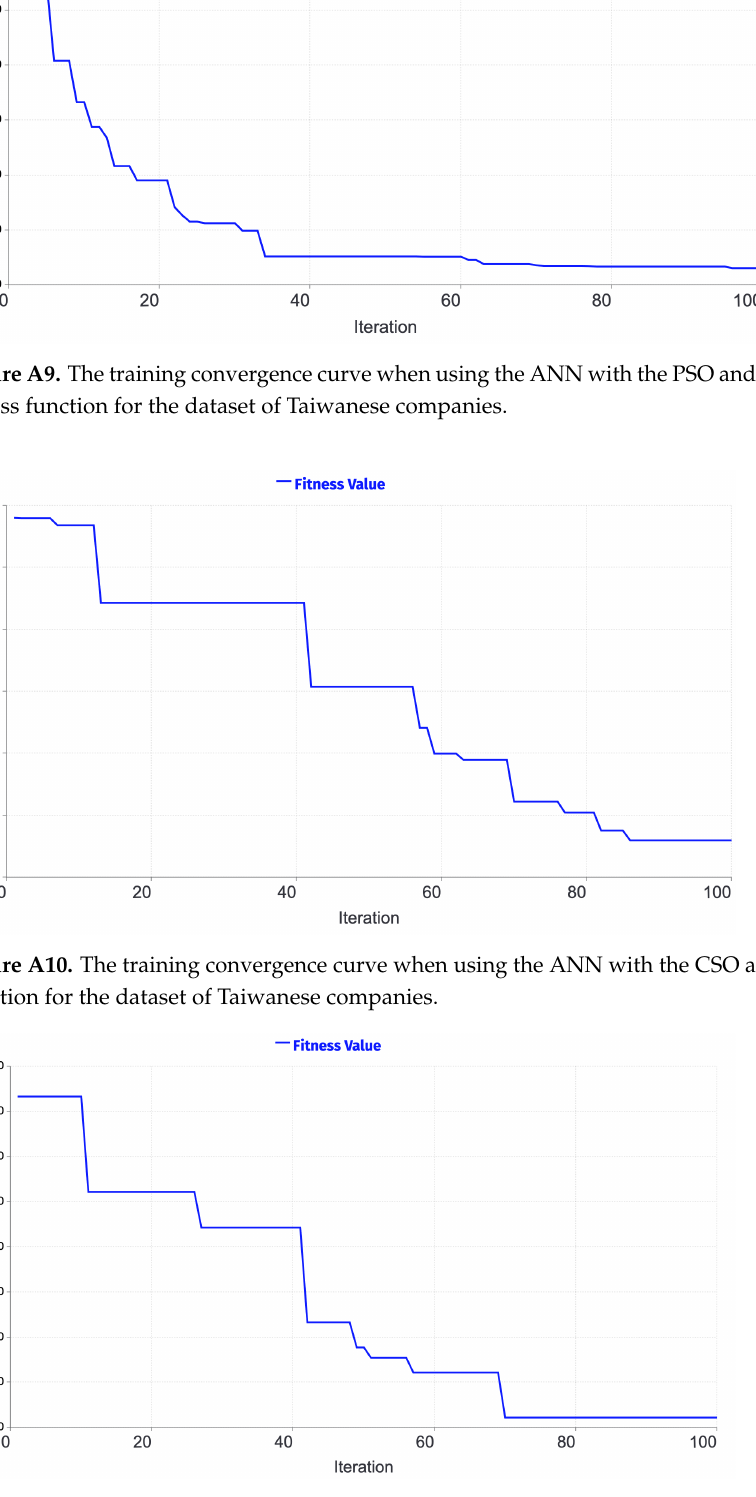
Figure A11. The training convergence curve when using the ANN with the CSO and the accuracy fitness function for the dataset of Taiwanese